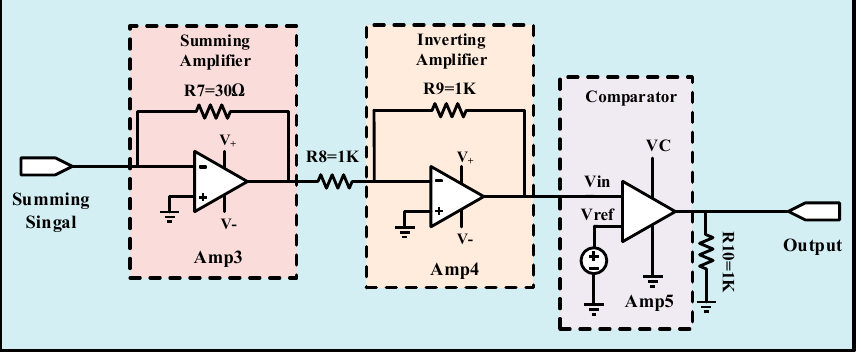
Figure 7. The circuit-level description of the output neuron.